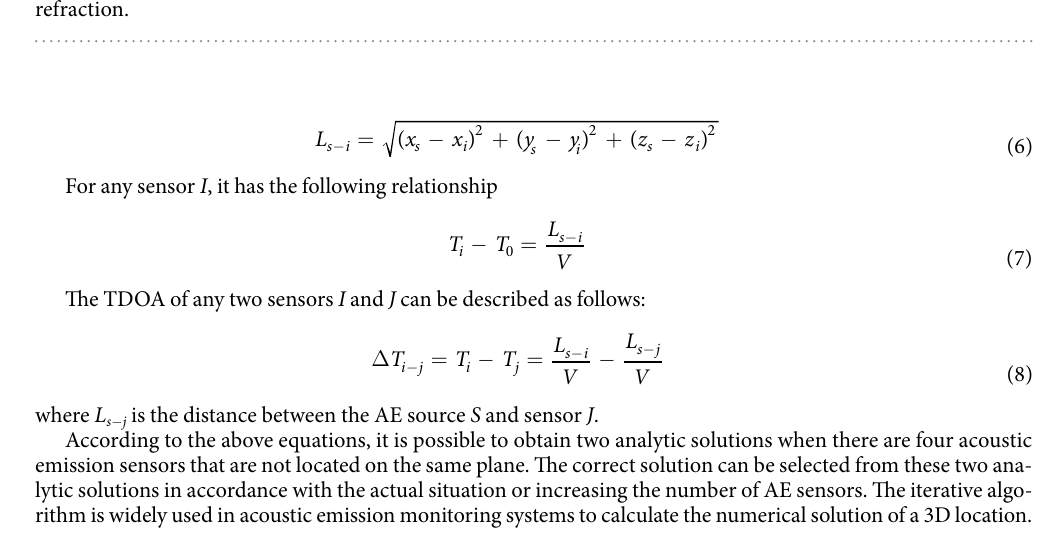
Figure 4. The propagation paths of the traditional location method and the new location method considering